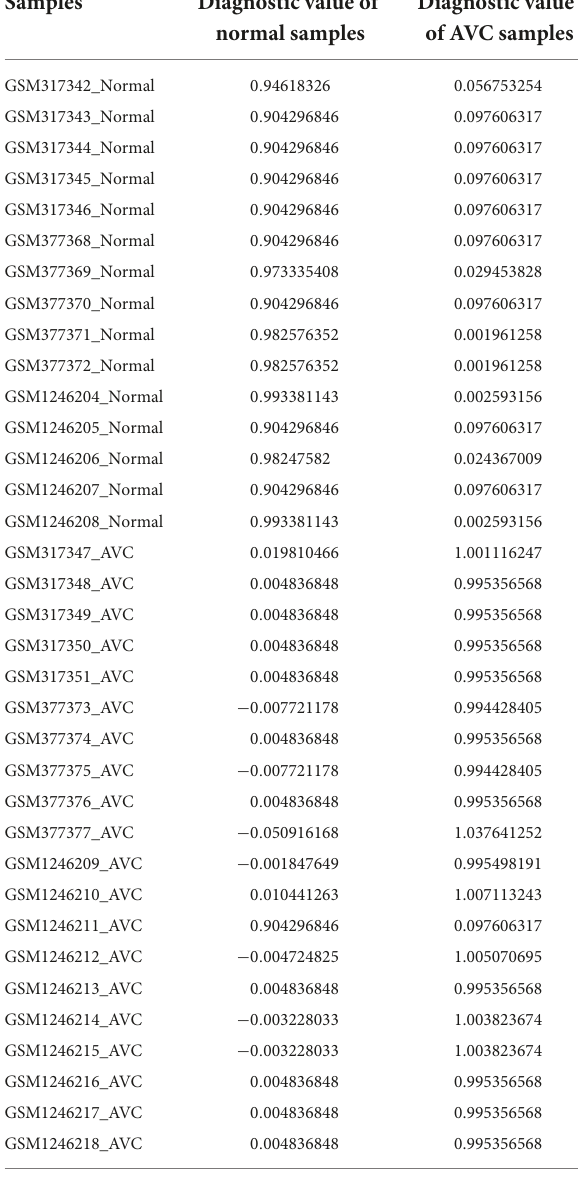
TABLE 5 Diagnostic value for all samples of the combined dataset of GSE12644 and GSE51472. Samples